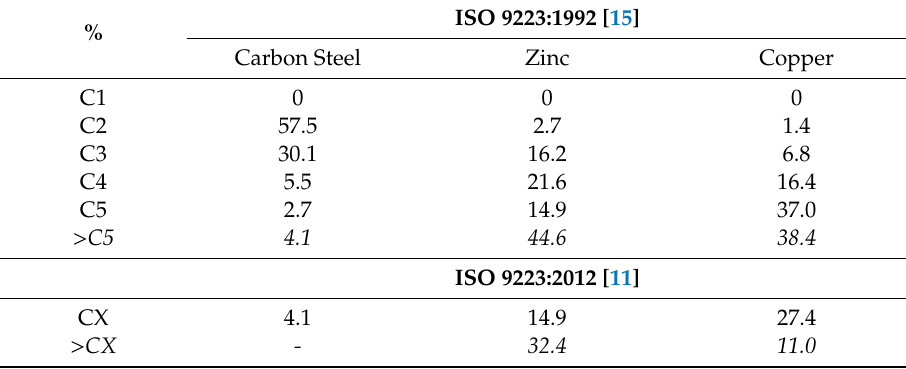
Table 8. Percentage distribution of atmosphere corrosivity categories in the Canary archipelago. ISO 9223:1992 [15] % Carbon Steel